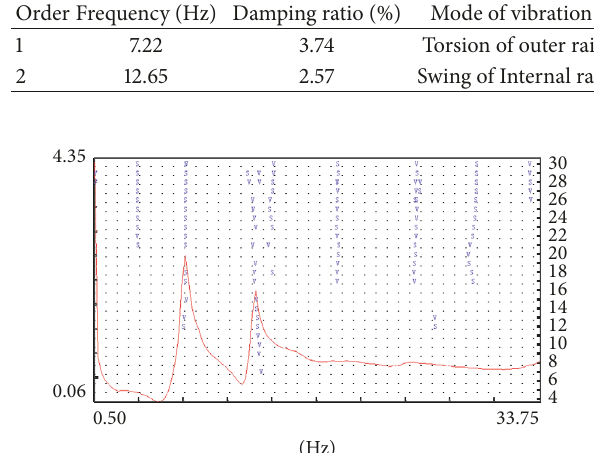
Figure 2: The stable diagram of the mode experiment for a certain point of force